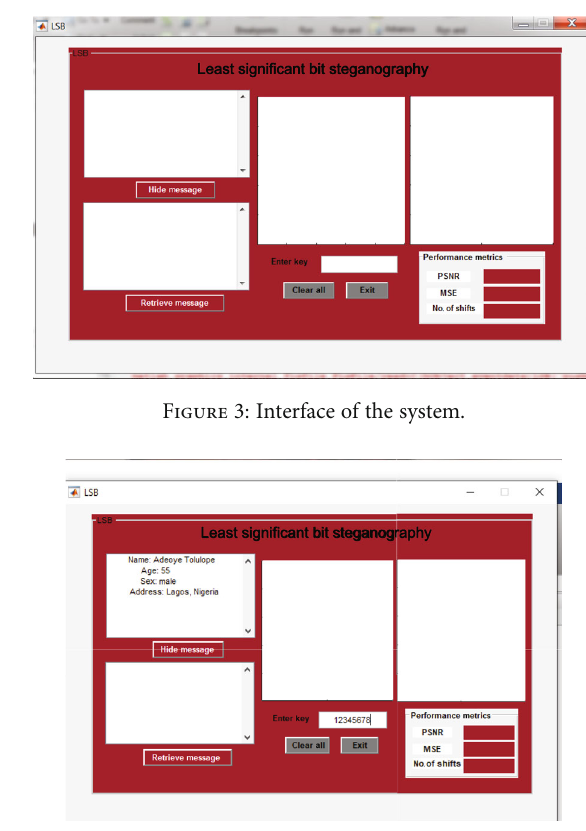
Figure 4: Interface showing text and stego key entered.